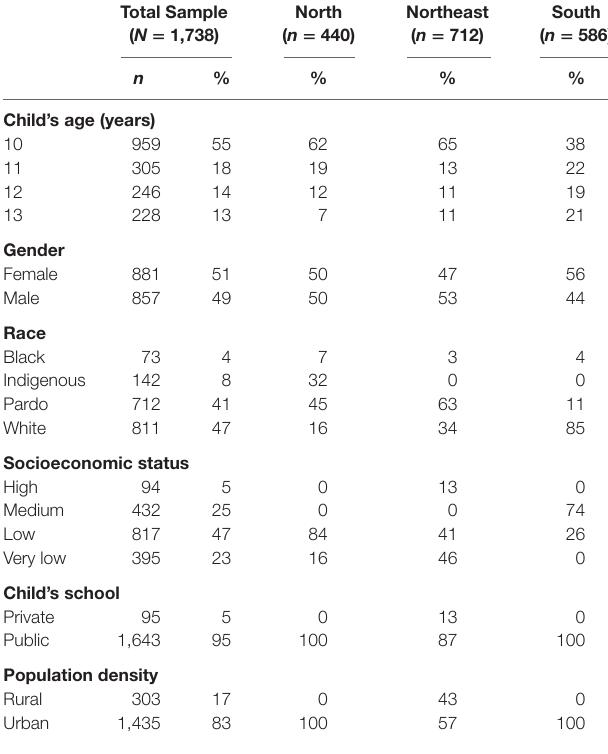
TaBle 1 | Sample demographics by